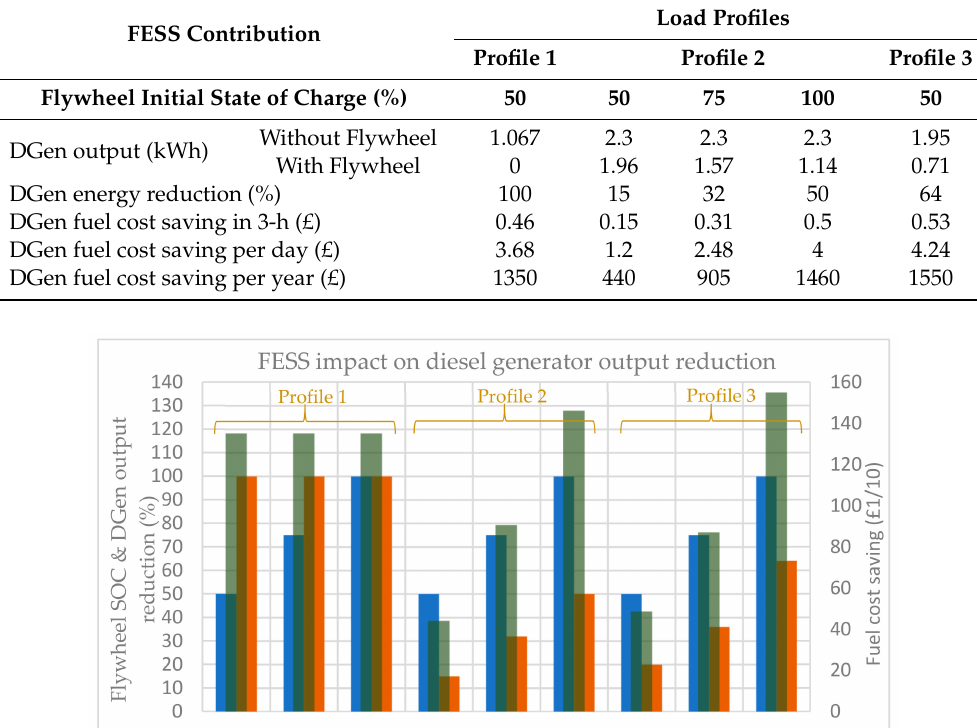
Table 4. FESS impact on reducing generator fuel consumption and fuel cost.